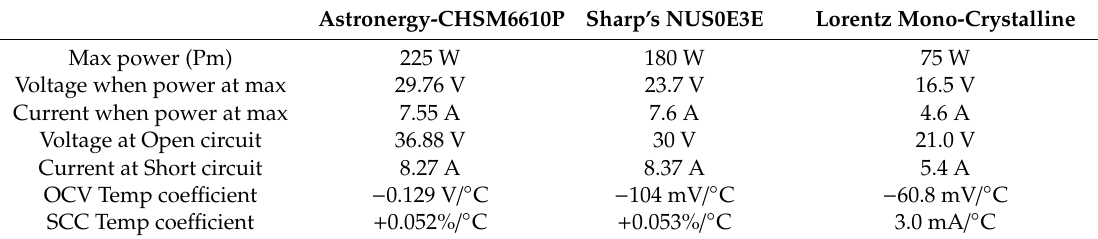
Table 1. The used PV panel’s manufacturer specifications.